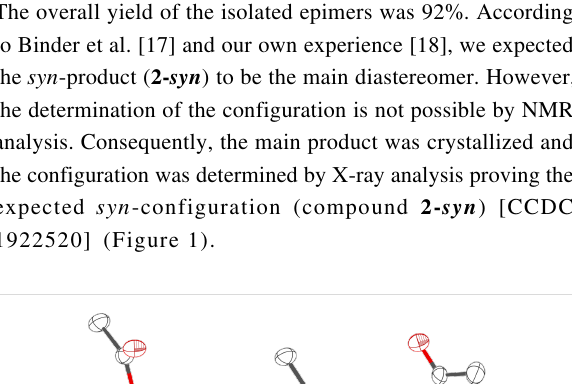
Epimer 2- syn was applied to Zemplén conditions prior to the ozonolysis. Conventional work-up, neutralization with acidic ion exchange resin followed by filtration and removal of the solvent under reduced pressure, led to precipitation of com- pound 3- syn , thereby causing problems during the